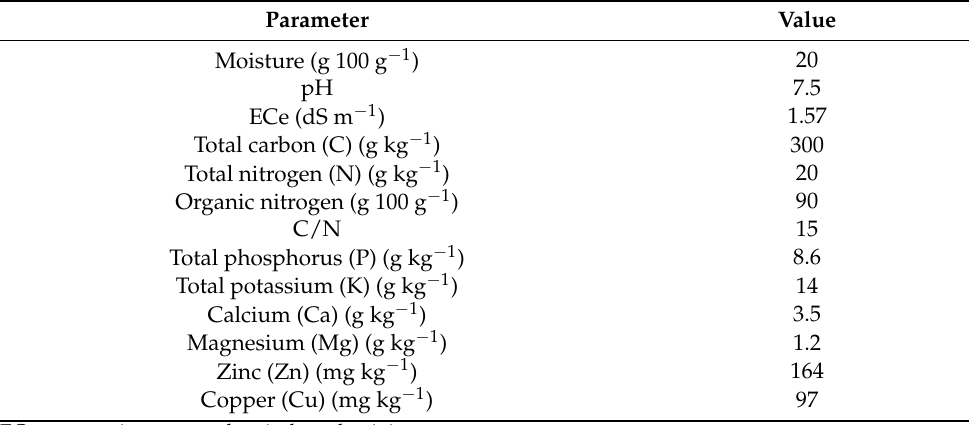
Table 6. Physic-chemical properties of Bio Vegetal green compost (Tersan Puglia, Modugno, Italy). All values are expressed as dry